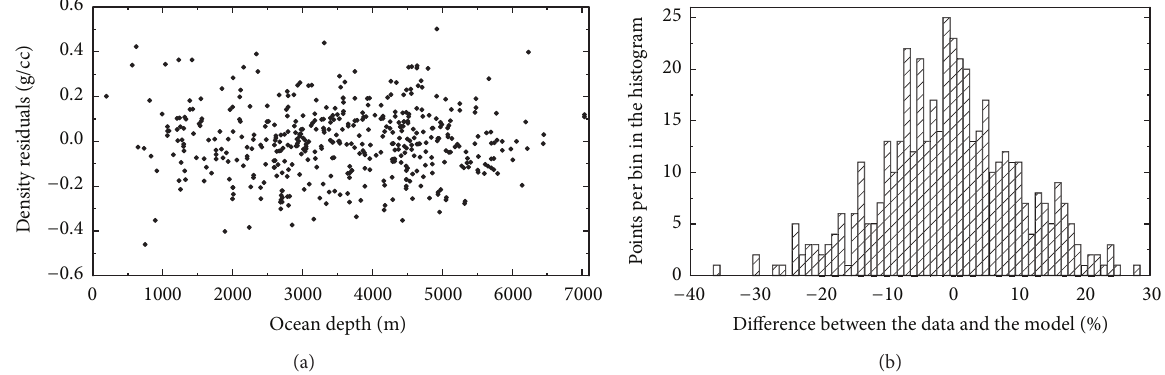
Figure 6: Errors of the upper sediment density equation in (1). Scatter plot and histogram of the differences between the measured and theoretical density values within the upper sedimentary layer ( 𝑑 𝑠 < 50 m). The density differences are plotted with respect to the oceanic depth. Statistics of the differences: standard deviation = 0.16g/cm 3 , max = 0.50 g/cm 3 , and min = − 0.46 g/cm 3 . The histogram shows a relative distribution of the density differences.